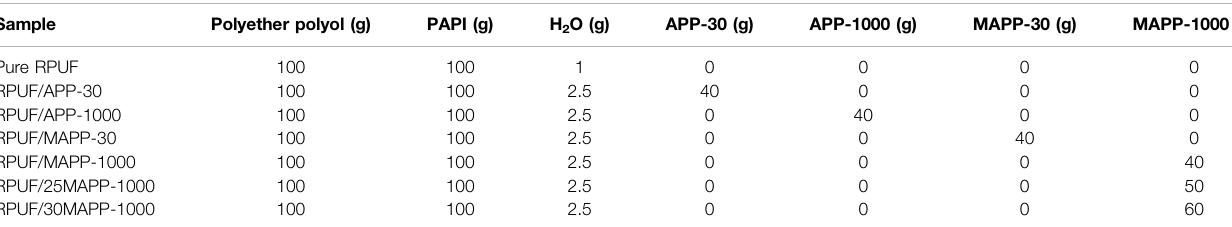
TABLE 1 | Formulas compositions of RPUF